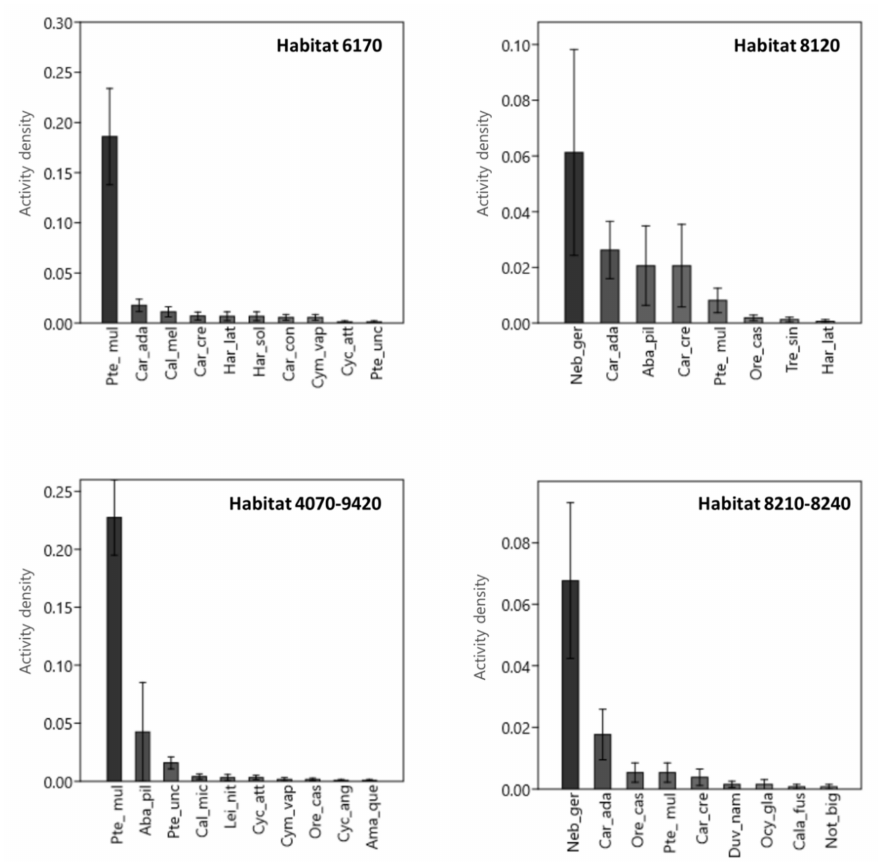
Figure 3. Average species activity density ( y -axis) recorded in each of the Nature 2000 habitat types. Habitat types: 6170 = alpine and subalpine calcareous grasslands; 8120 = calcareous and calcshist screes of the montane to alpine levels; 8210-8240 = limestone pavements and calcareous rocky slopes with chasmophytic vegetation; 9420-4070 = alpine Larix decidua and/or Pinus cembra forests and bushes with Pinus mugo and Rhododendron hirsutum . The whisker intervals represent a 95% confidence interval based on the standard error. Species abbreviation refers to Table S1.